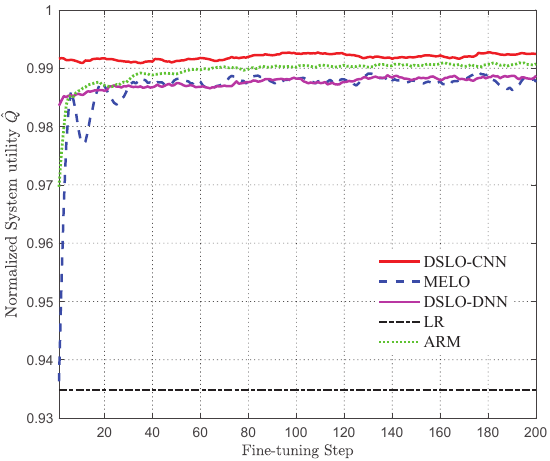
Figure 12. Test performance of different computational offloading